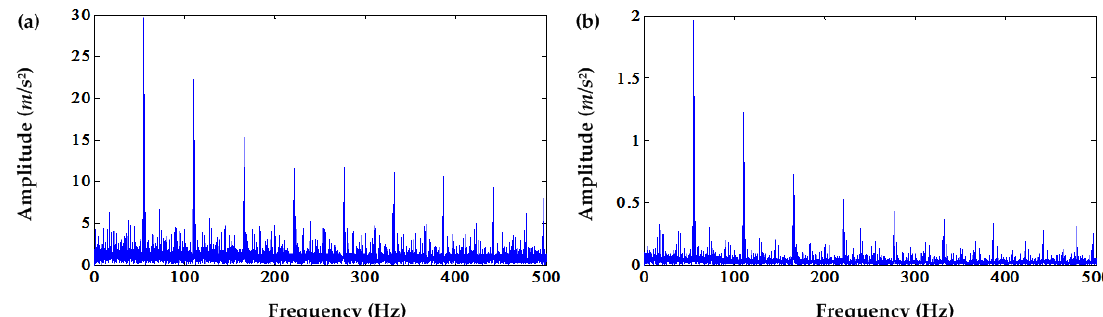
Figure 22. ( a ) Squared envelope spectrum after the first DC offset cancellation; ( b ) envelope spectrum of the original time synchronous signal.